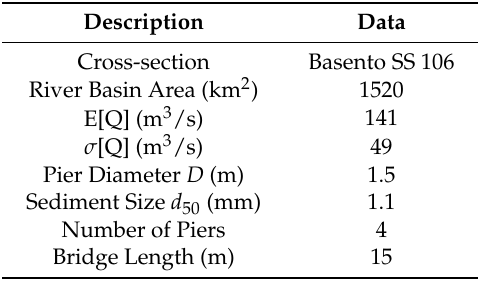
Table 1. Main characteristics of the selected study case.